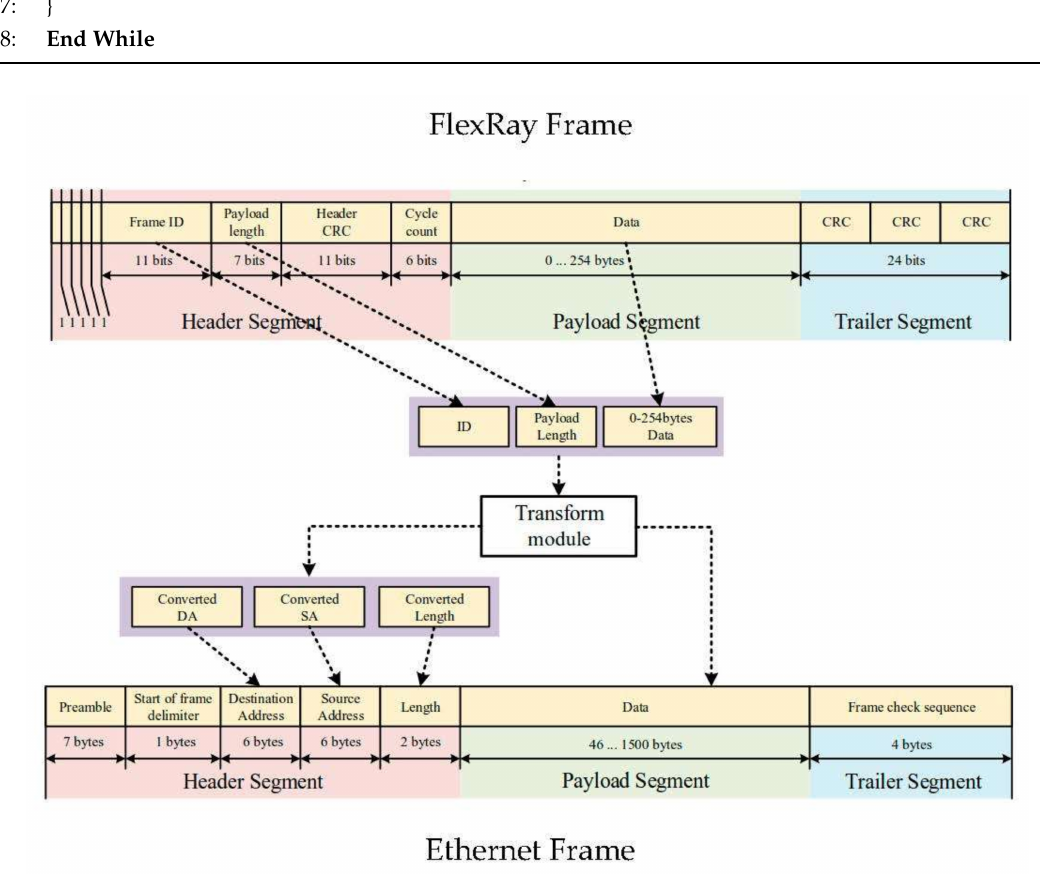
Figure 3. FlexRay frame transformed to Ethernet